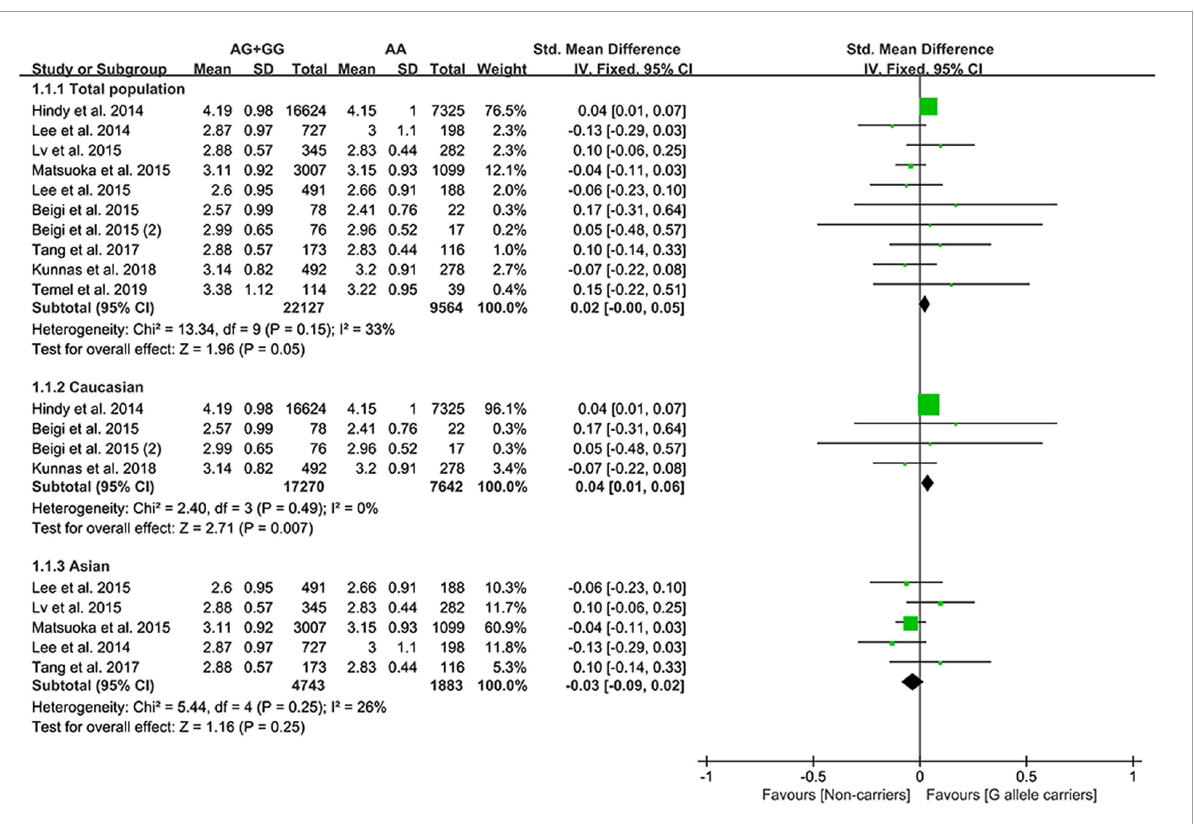
FIGURE3 A forest plot of lncRNA rs4977574 variant with circulating LDL-C